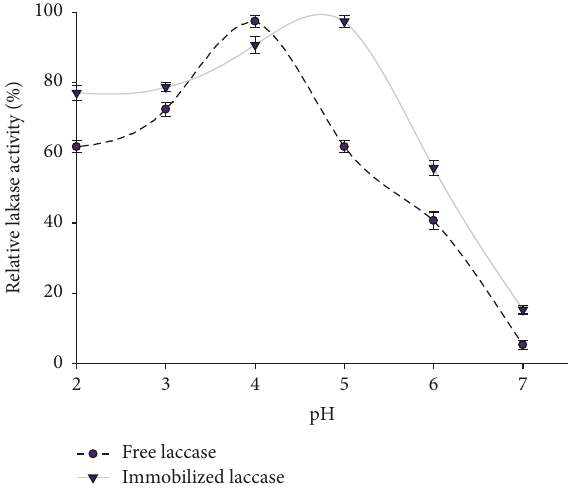
Figure 8: Effect of pH on enzyme activity between immobilized and free